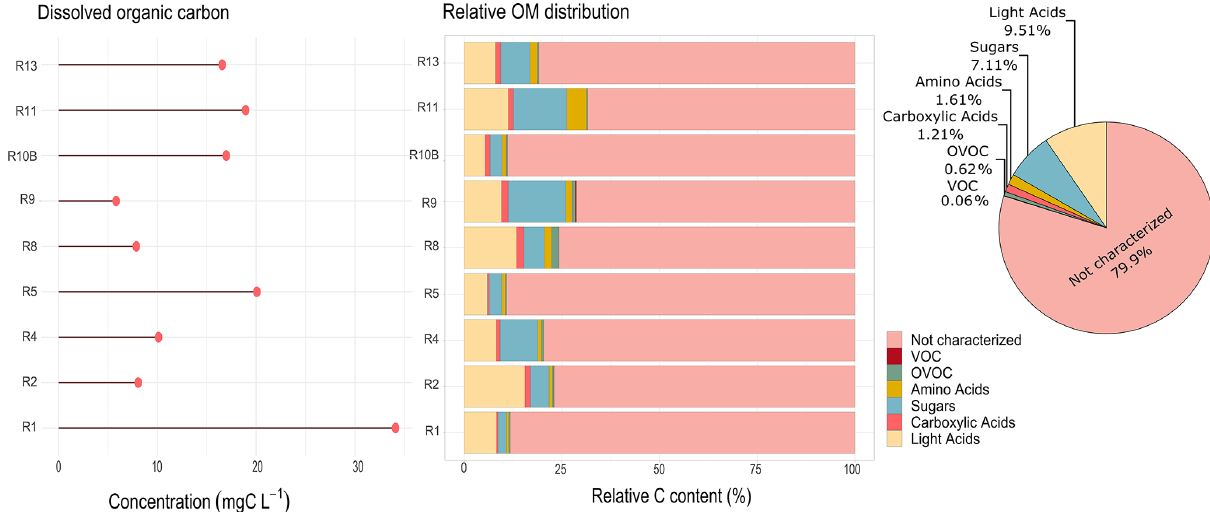
Figure 7. Total dissolved organic carbon and relative contribution of organic compounds to the total organic content, observed for each cloud event and the relative average of total contributions during the field campaign in Réunion. Light acids represent the sum of major light organic acids (acetate, formate, oxalate, and lactate). R1 to R13 refer to individual cloud